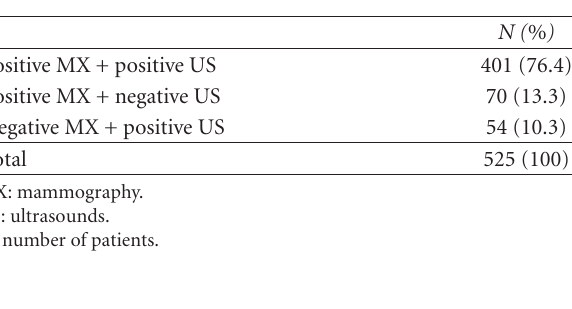
Table 1: Breast cancer diagnosis. Table 2: Histopathologic types.